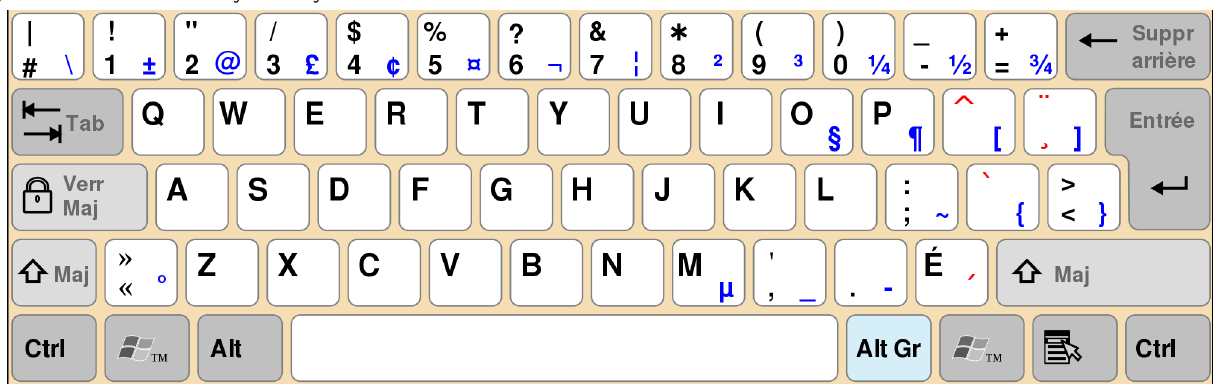
Figure 2. Canadian French keyboard